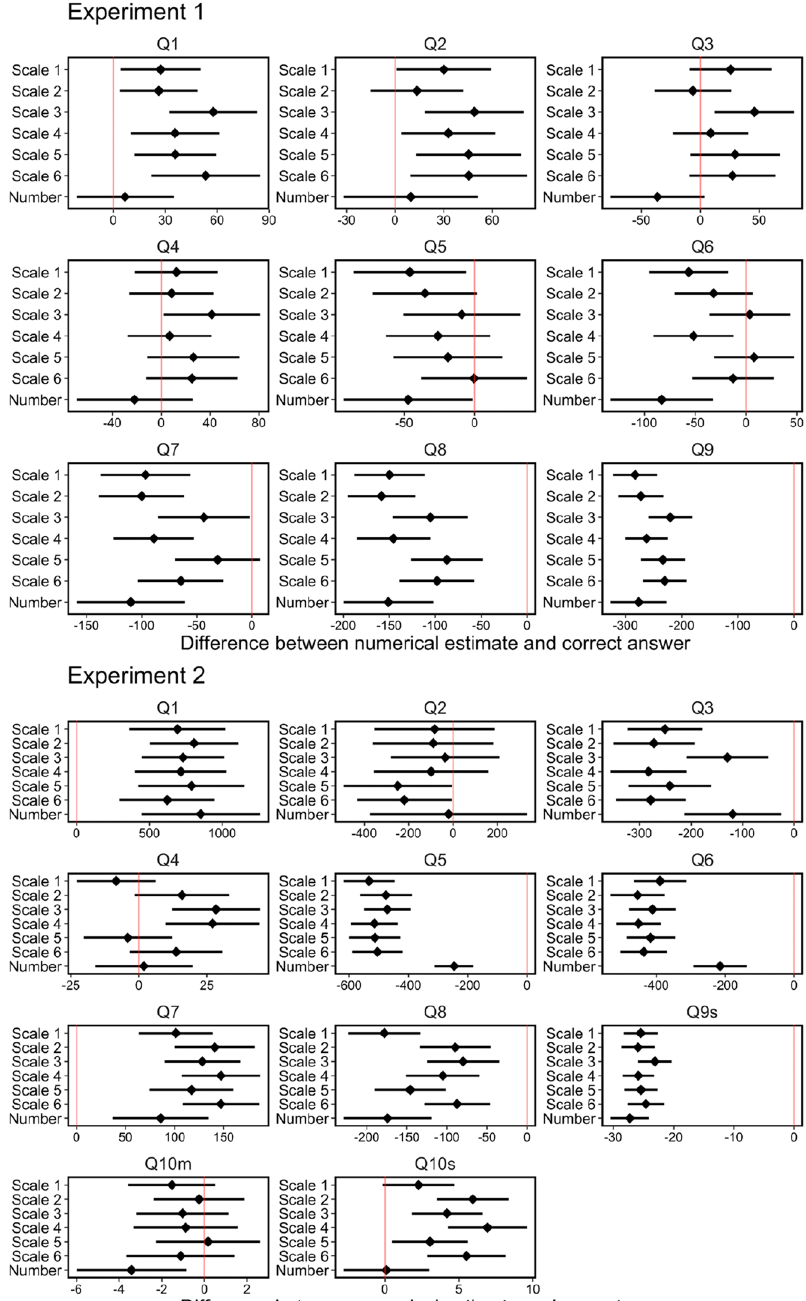
Figure 6. Difference between numerical estimate and correct answer. The point indicates the median, and the error bar indicates a 95% confidence interval. The red line indicates “no deviation” from the correct